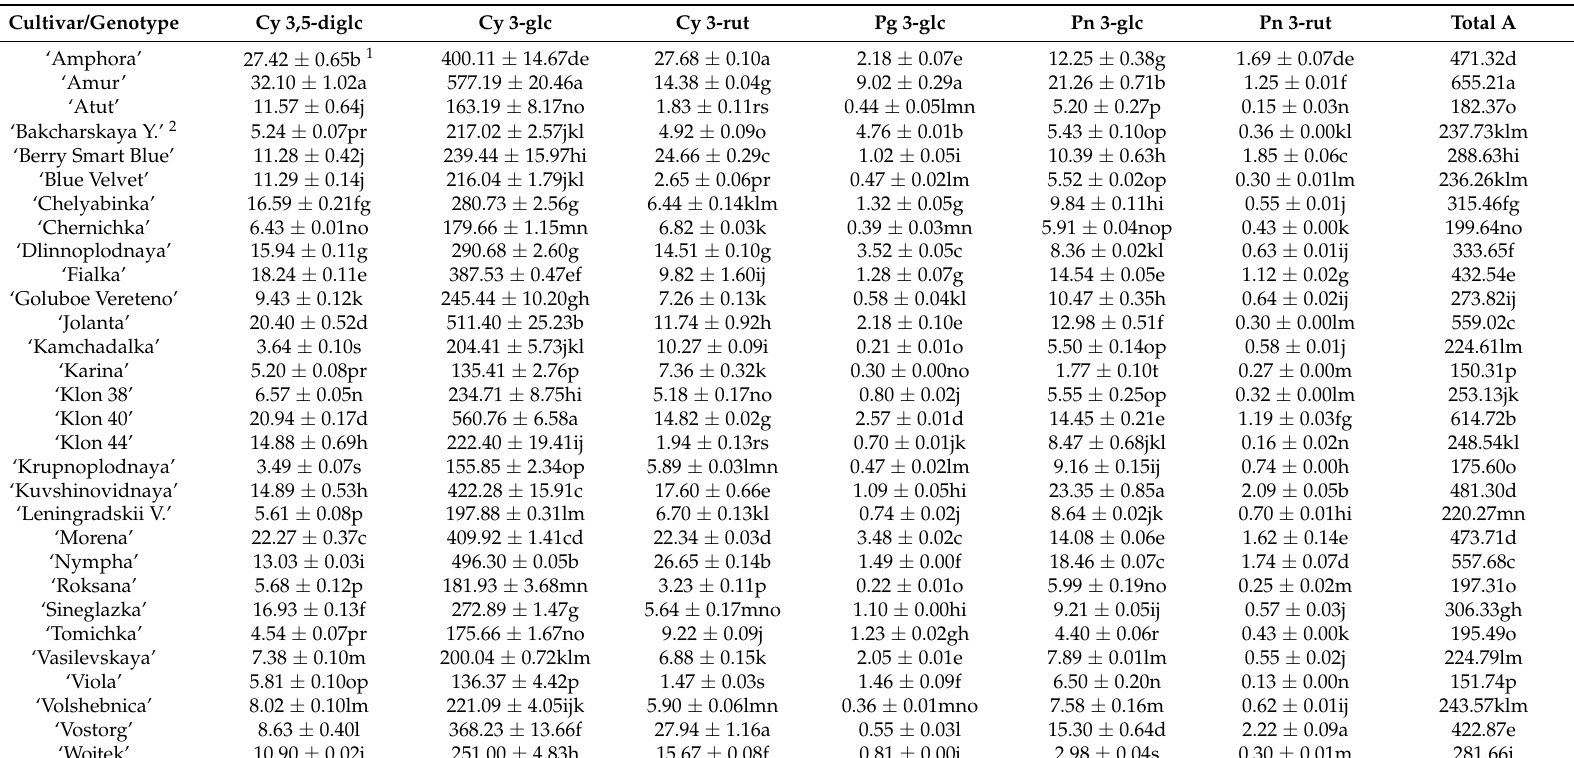
Table 3. Anthocyanin content (mg/100 g fw) of different blue honeysuckle cultivars and